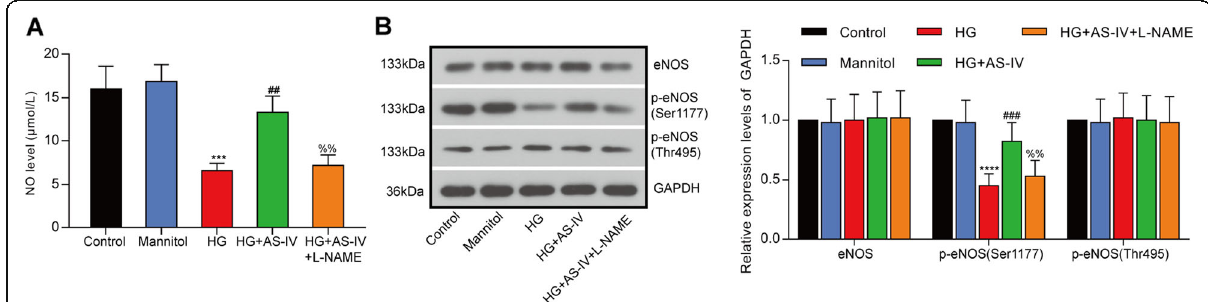
Fig. 5 AS-IV reversed HG-induced eNOS impairment in HRGECs. a The NO producing ability in HRGECs after high glucose treatment was assessed by Nitric Oxide (NO) assay kit. All results were expressed as mean ± SD ( n = 3). b The expressions of eNOS, p-eNOS (Ser1177) and p-eNOS (Thr495) after high glucose treatment in HRGECs were detected by western blot. **** p < 0.0001, *** p < 0.001 vs. control; ### p < 0.001, ## p < 0.01 vs. HG; %% p < 0.01 vs HG +